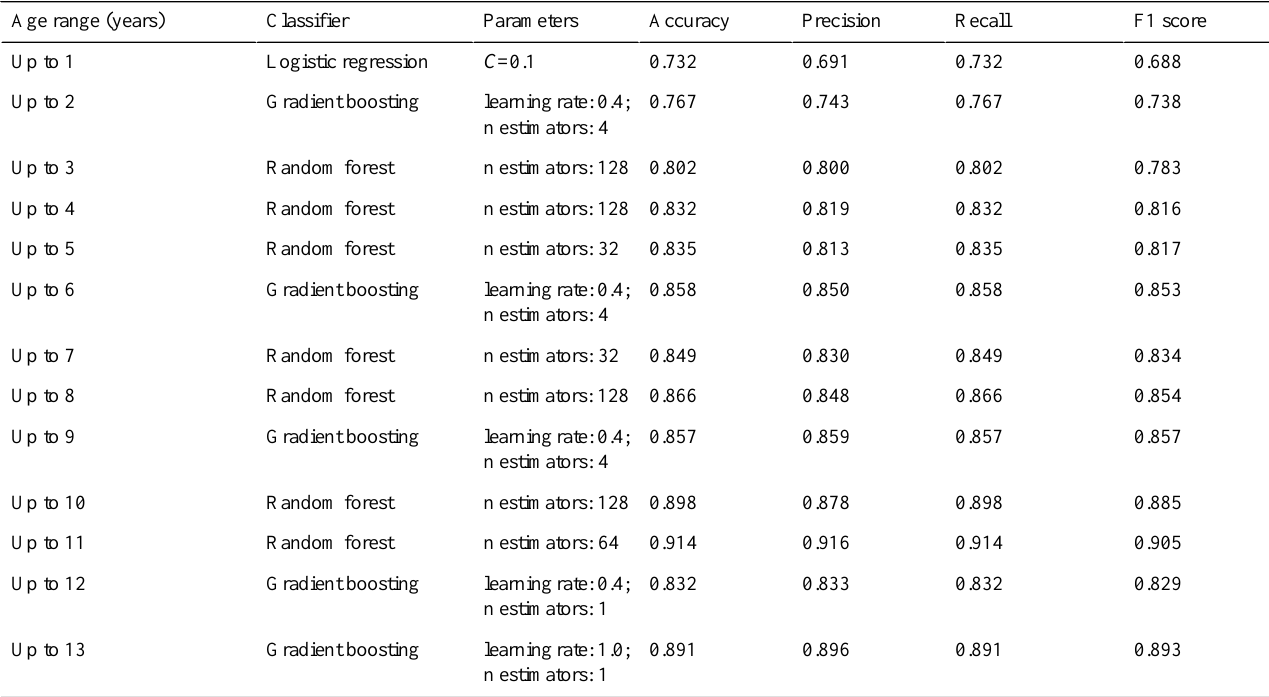
Table 7. Model learning results based on disease diagnostic and prescription data.